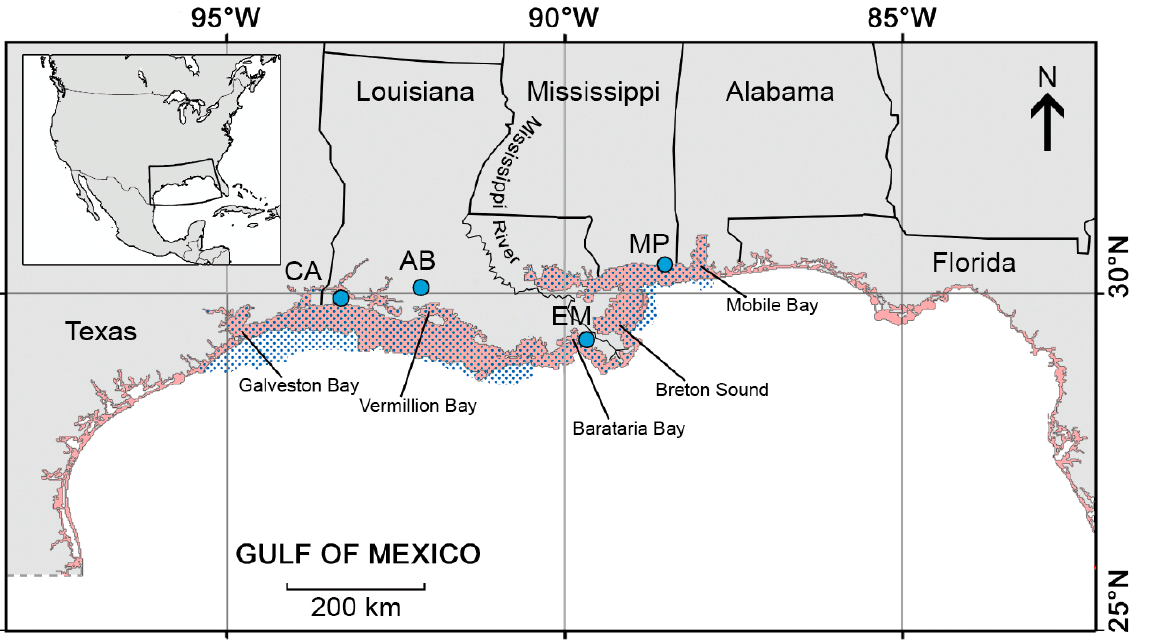
Figure 1. Coastal waters inhabited by Gulf menhaden in the United States. Red shading indicates the spatial distribution of commercially exploitable aggregations of Gulf menhaden in the northern Gulf of Mexico, as indicated by commercial purse seine sets during 1986–2011 (from Figure 5.11 in [8]), and represents an area of ~40,000 km 2 . Blue shading indicates the area assumed inhabited by 75% of the population (see Results section). Blue dots show locations of processing plants at Cameron (CA), Abbeville (AB), Empire (EM) and Moss Point (MP).